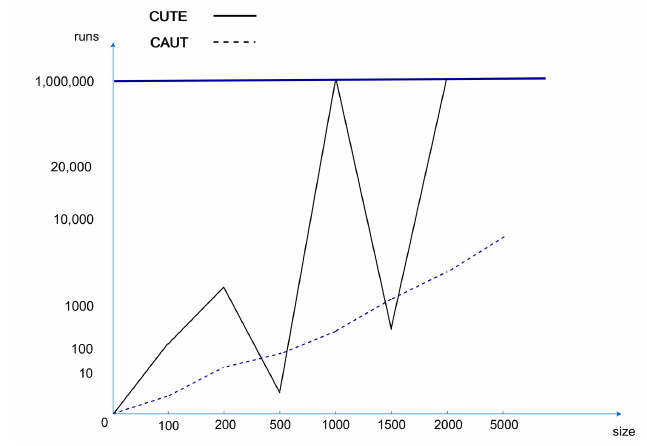
Figure 8. Experimental